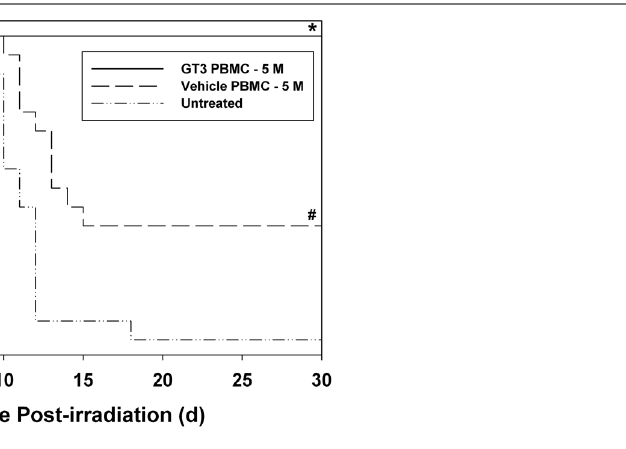
Figure 2. Evaluation of GT3-mobilized PBMC as a radiomitigator when administered 24 h after irradiation (11 Gy). Mice were transfused (iv) with 5 million PBMC in a volume of 100 m l of PBS containing 1% FBS. Survival was monitored for 30 days after irradiation. *Denotes statistical significance between GT3- mobilized PBMC-treated and vehicle-mobilized PBMC-treated or untreated groups ( p # 0.001). # Denotes statistical difference between vehicle-mobilized cell-treated and untreated groups ( p 5